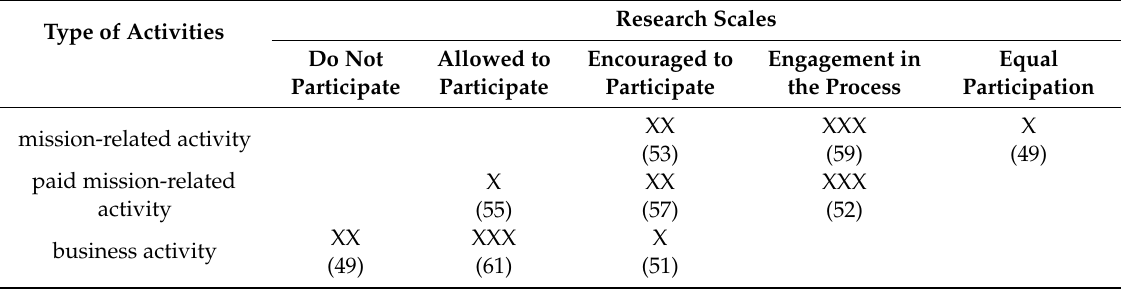
Table 3. Stakeholders engagement in SEO operation depending on the type of